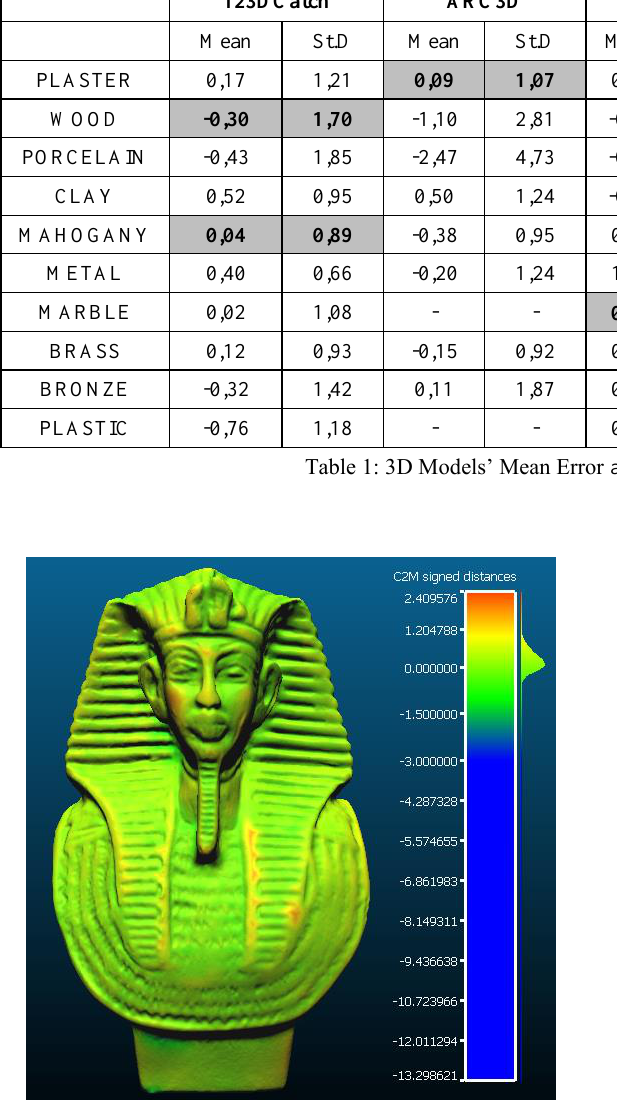
Figure 8: Computing distances between aligned